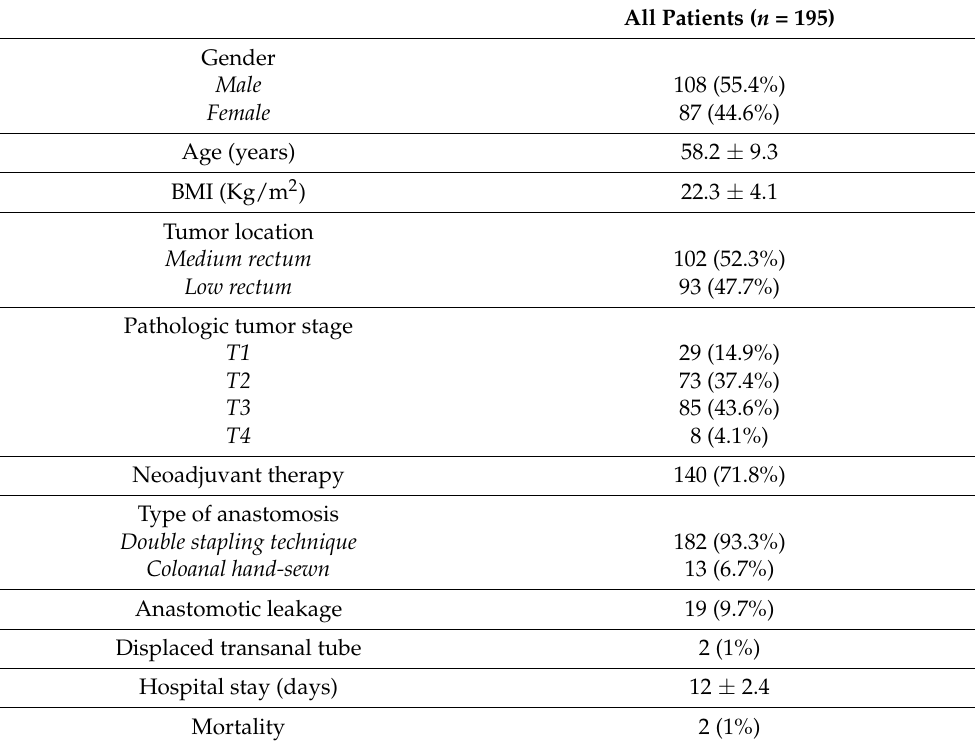
Table 1. Perioperative characteristics of the 195 patients who had laparoscopic TME and transanal tube for rectal cancer.